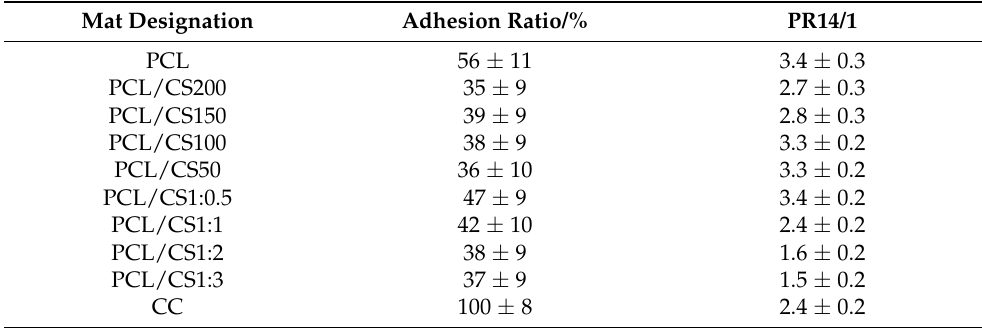
Table 3. Adhesion ratio of HFFF2 cells to the electrospun PCL mats with CS flakes from different sizes and in different ratios and cell proliferation obtained by the ratio between cell population on day 14 and on day 1 (PR14/1). Uncertainty is the combined standard